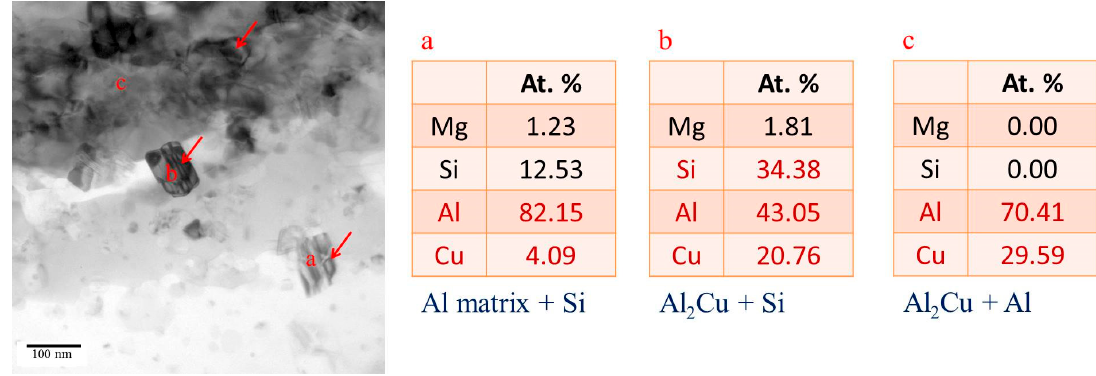
Figure 13. EDS analysis of eutectic Si particles.